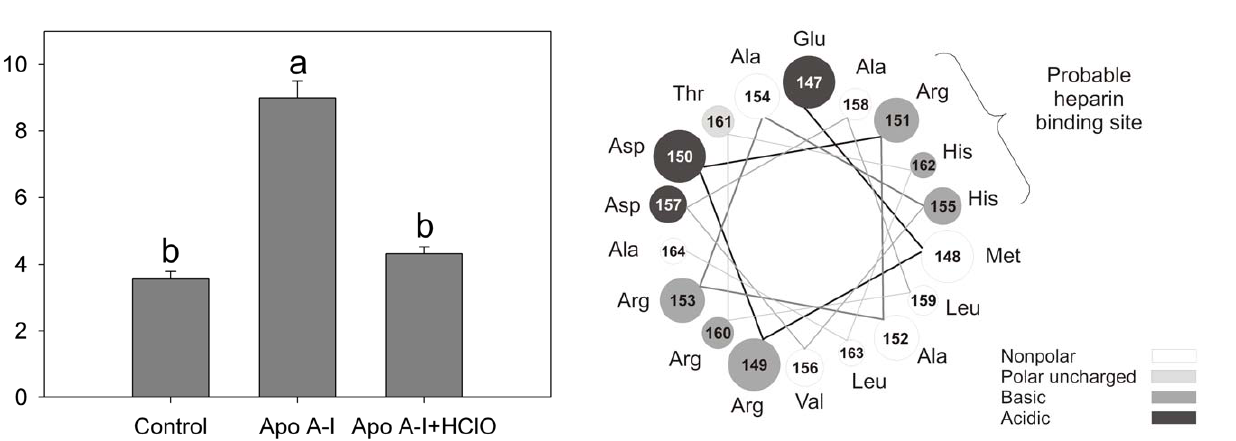
Figure 9. Cholesterol efflux mediated by HClO-processed apoA-I: Chinesse Hamster Ovary Cells were labeled with 3 H Chol and incubated with apoA-I as indicated in Methods. Results are shown as the % of radioactivity removed by apoA-I, either being treated (ApoA-I + HClO) or not (ApoA-I) with , 50 m M HClO. Column labeled as Control refers to cells incubated under the same conditions but in the absence of the protein. Bars correspond to means 6 SE.